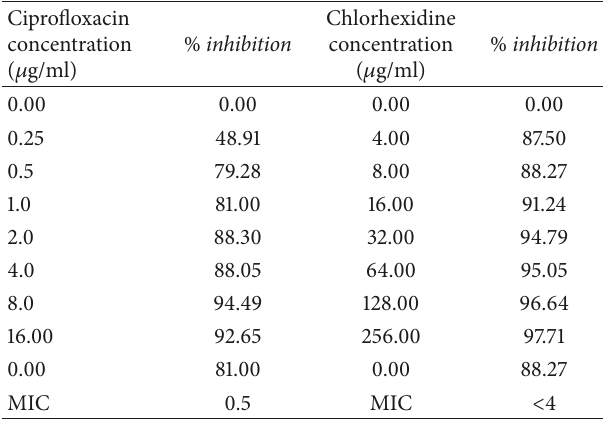
Table 2: Minimum inhibitory concentration of ciprofloxacin and chlorhexidine against Streptococcus mutans .